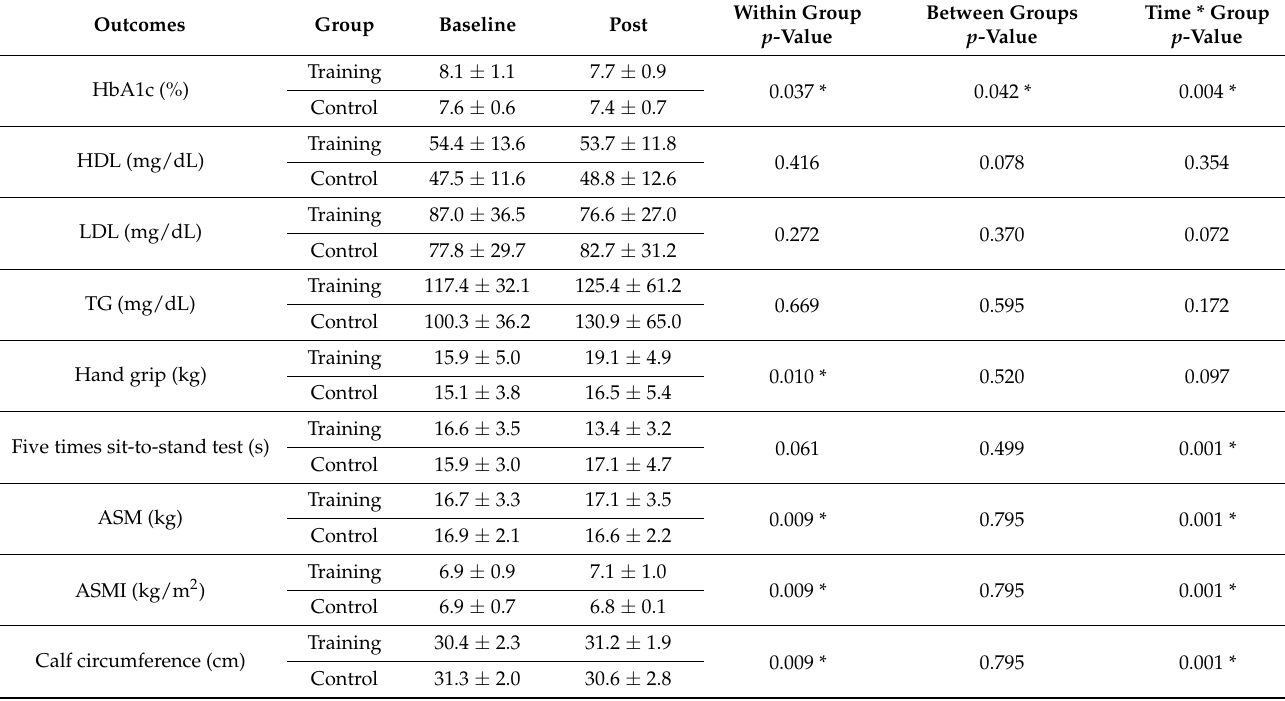
Table 2. Changes in outcomes between groups after 12 weeks of